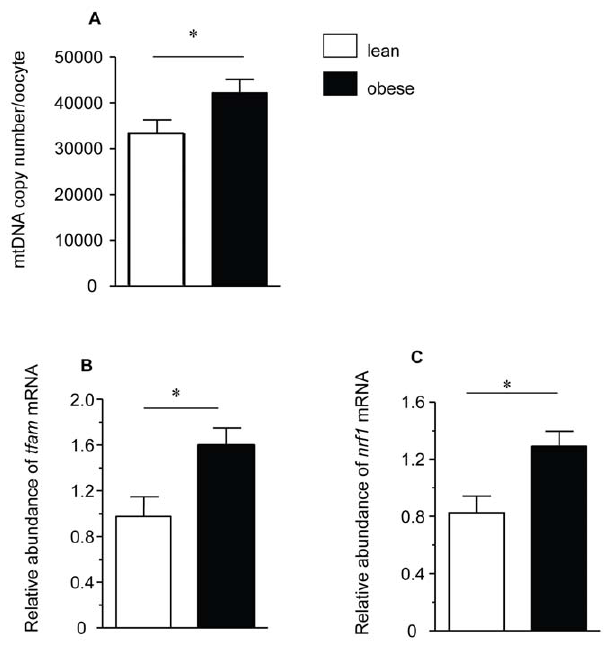
Figure 4. Mitochondrial biogenesis is up-regulated in oocytes from obese mice. (A) mtDNA copy number in oocytes from lean (n=2 oocytes/8 females/group) and obese (n=2 oocytes/8 females/group) mice. Relative abundance of TFAM mRNA (B) and NR1m RNA (C) in oocytes from lean (n=20 oocytes/8 females/group) and obese (n=20 oocytes/8 females/group) mice. qPCR was used to determine the absolute mtDNA copy number and the amount of specific transcripts relative to the H2A mRNA.* p , 0.05. Data are mean 6 SEM.